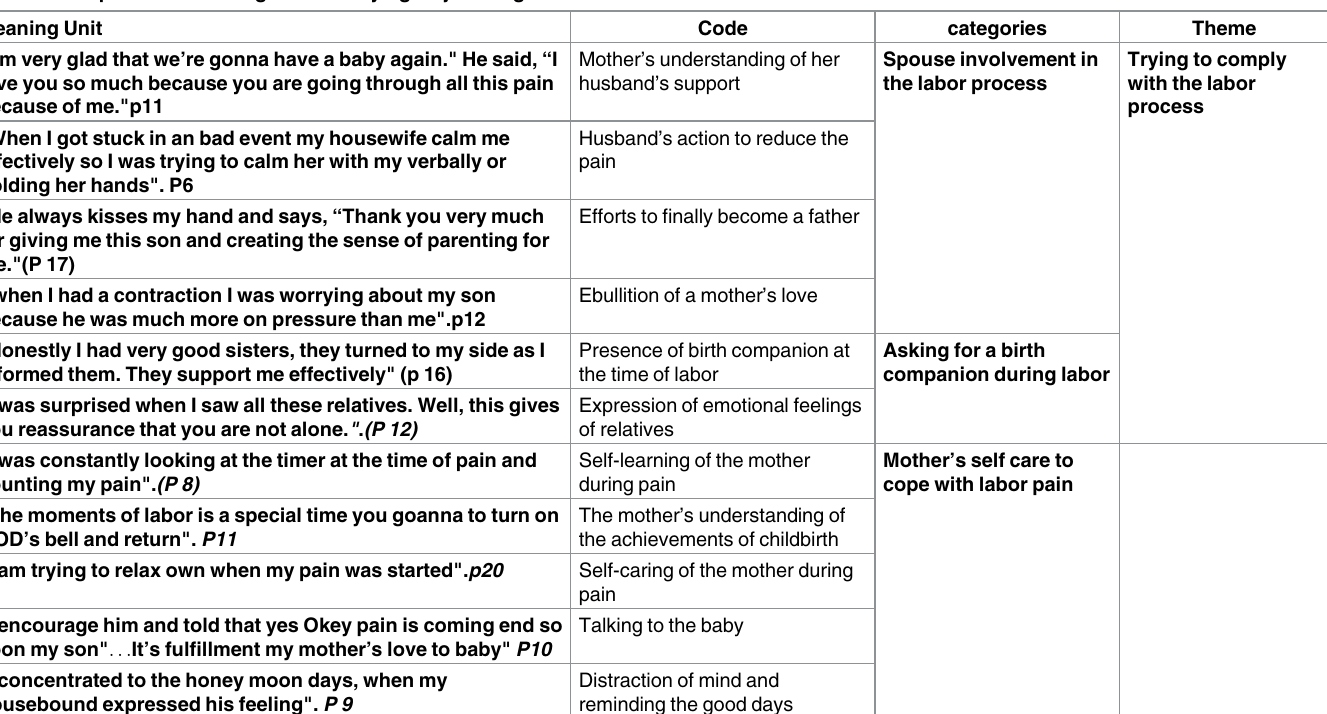
Table 2. The process of coding and identifying major